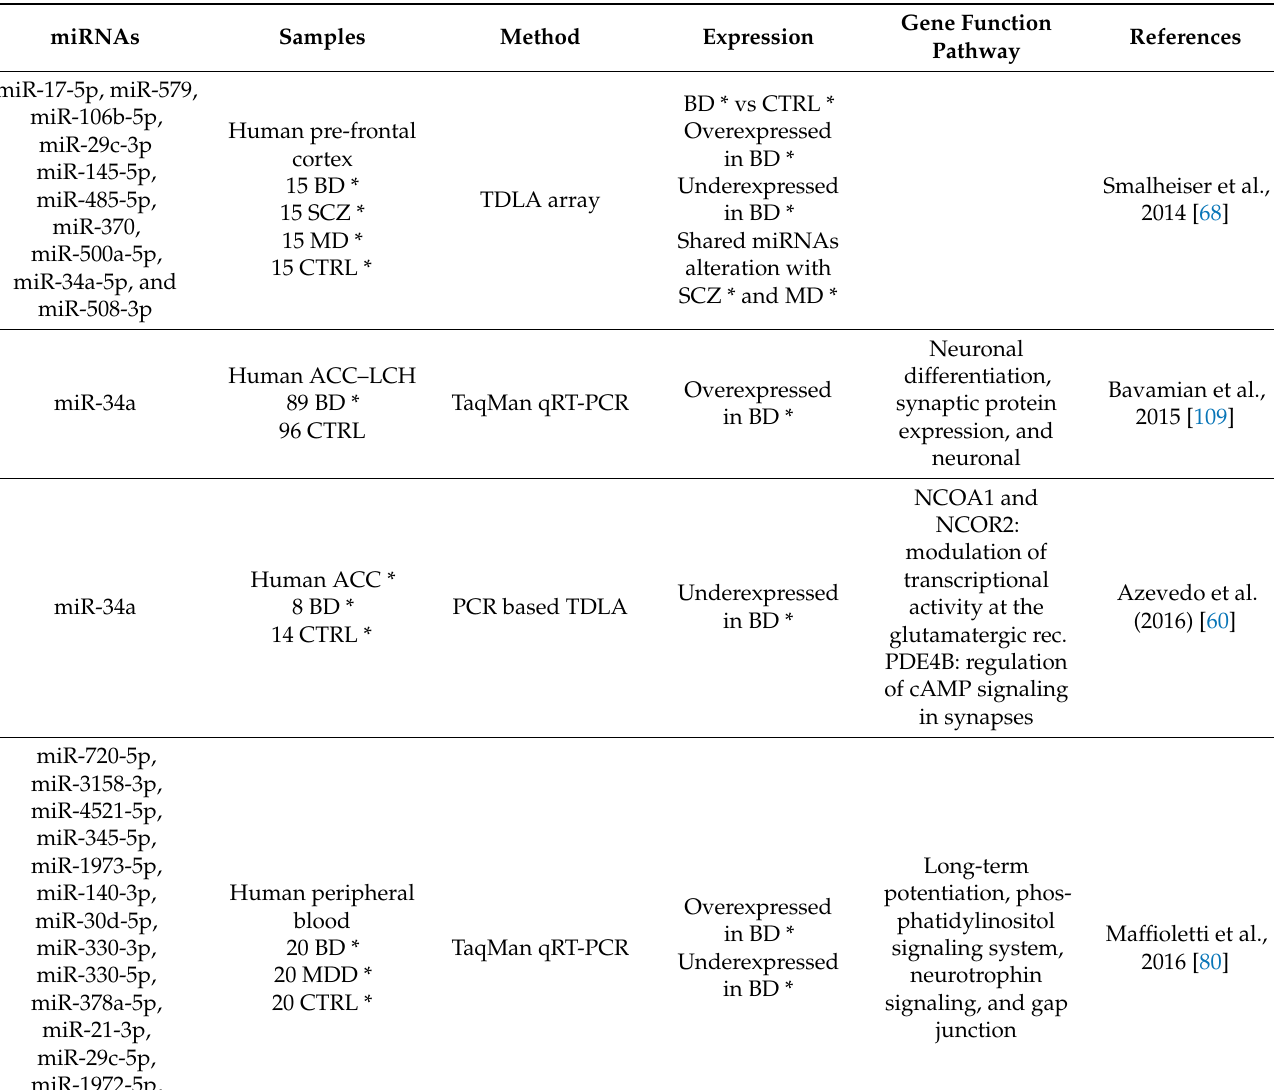
Table 1. MicroRNA expression studies in bipolar